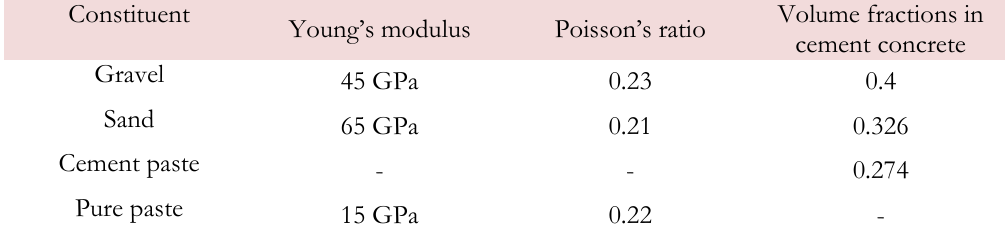
Table 1: Geometrical and mechanical properties of the four-phase composite.